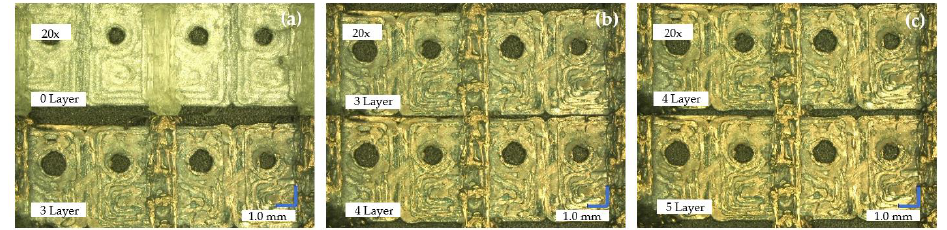
Figure 12. 3D printed sequins with conductive copper foil structures: ( a ) PLA LED sequins and ( b ) PLA RGB